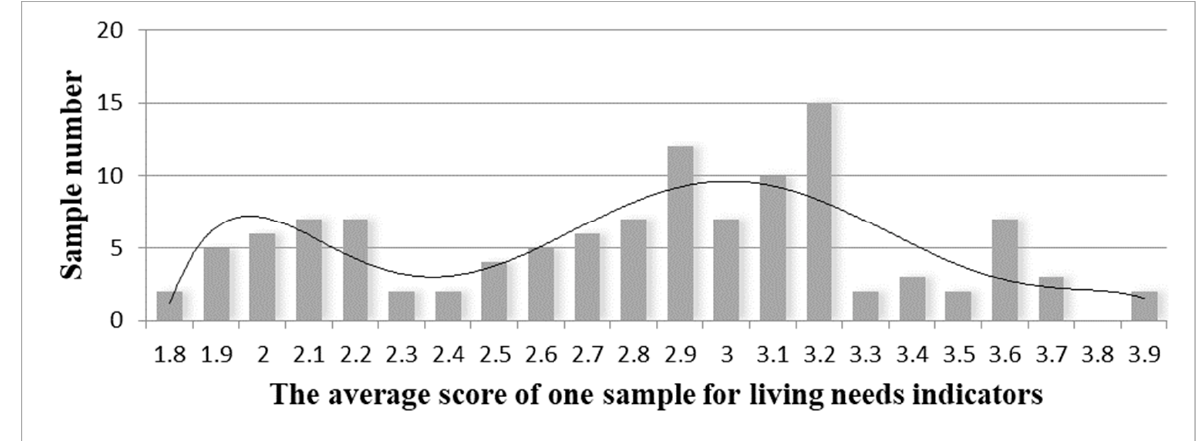
Figure 1. Frequency distribution of the average score of one sample for living needs.